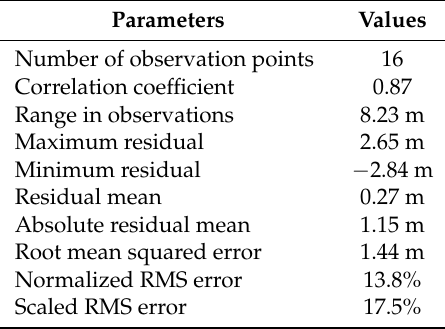
Table 2. Statistical results of simulated freshwater